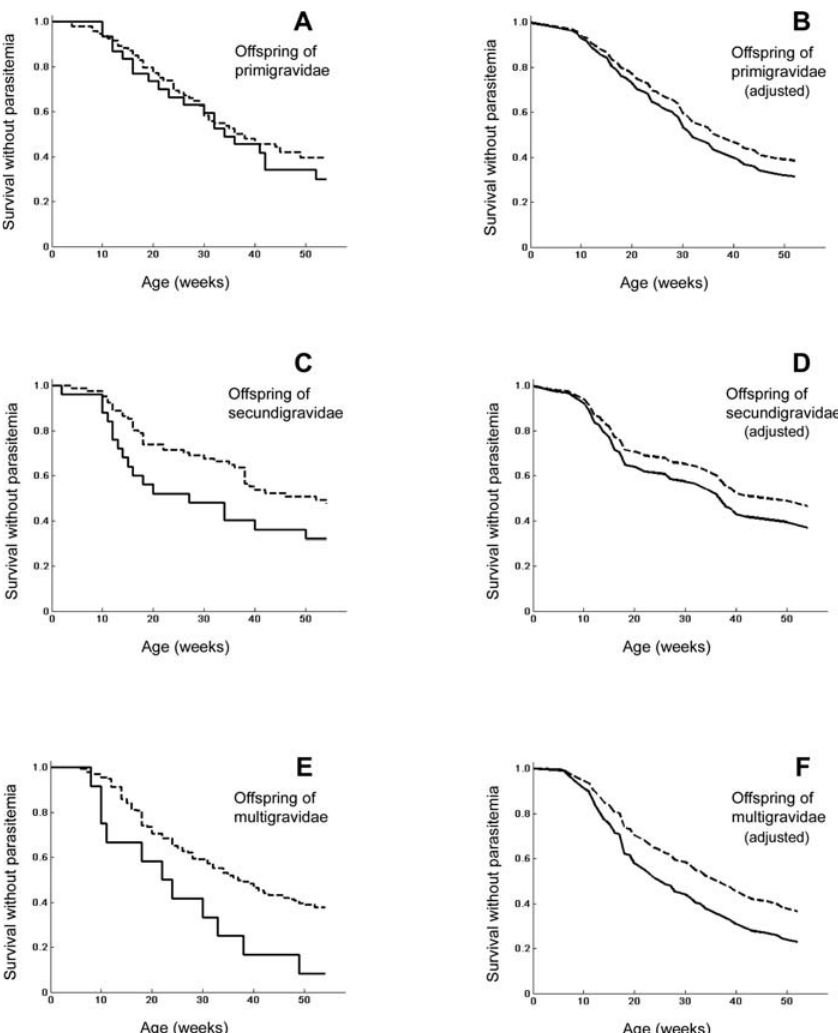
Figure 2. Kaplan-Meier Estimate of the Probability of Surviving without Parasitemia and Adjusted Estimate Using a Cox Model The graphs show the unadjusted (left panels) and adjusted (right panels) age at first parasitemia in first-born (A and B), second-born (C and D), or third- born or subsequent (E and F) offspring of PM-positive mothers (solid lines) versus PM-negative mothers (dashed lines). PM is associated with a significantly younger age at the time of first parasitemia among offspring of multigravidae (log rank, p ¼ 0.01), but not among offspring of primigravidae (log rank, p ¼ 0.48) or secundigravidae (log rank, p ¼ 0.06). Adjustment estimates using a Cox model did not change statistical significance in any gravidity group. DOI: